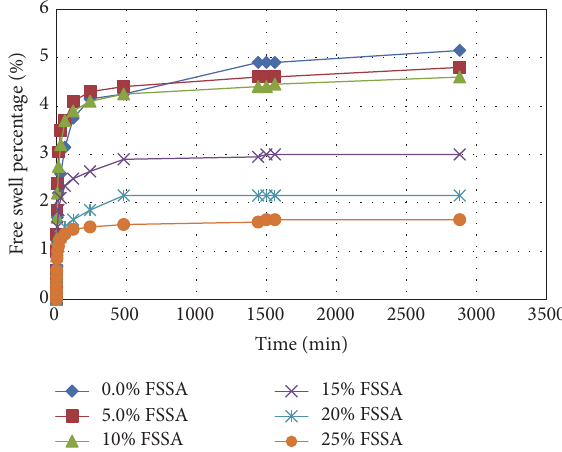
Figure 5: Free swell percentage versus time for samples with different FSSA contents.